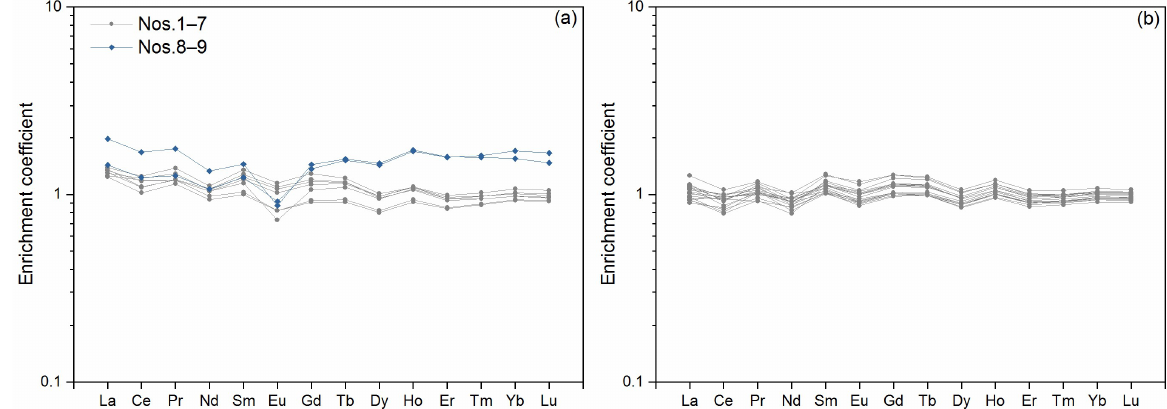
Table 3. Trace elements data of Wufeng-Longmaxi and Niutitang samples. For- mation Sample Number Depths Li Be Sc